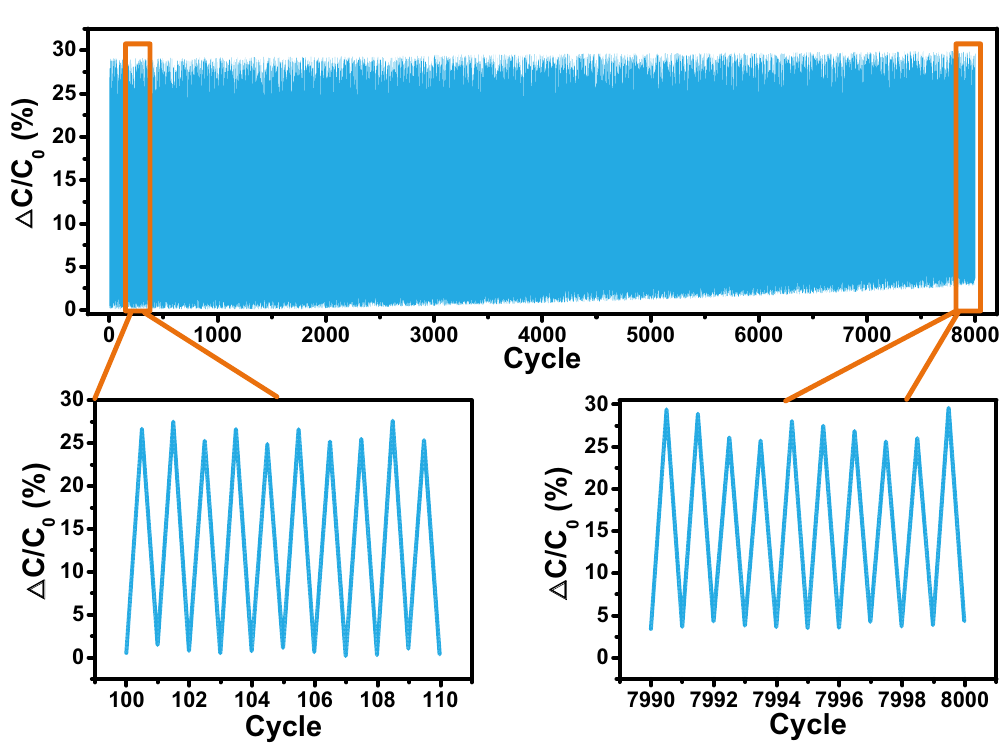
Figure 3. Reliability test of the fabricated sensor under the repeated 8000 compression-release